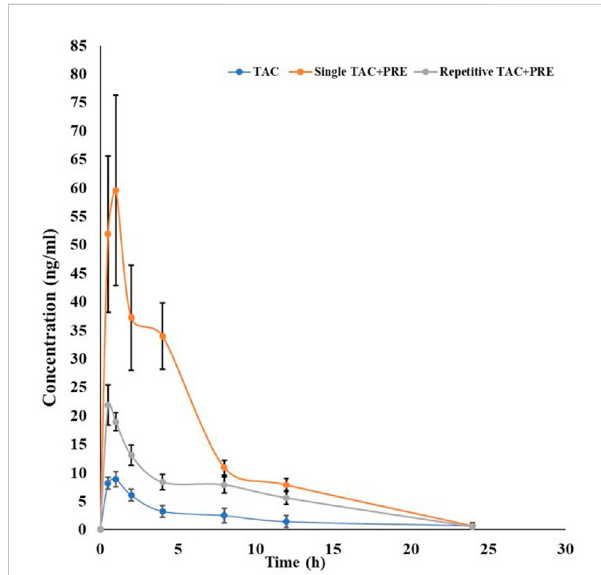
FIGURE 4 Area under plasma TAC concentration vs. time pro fi le (single- dose study).